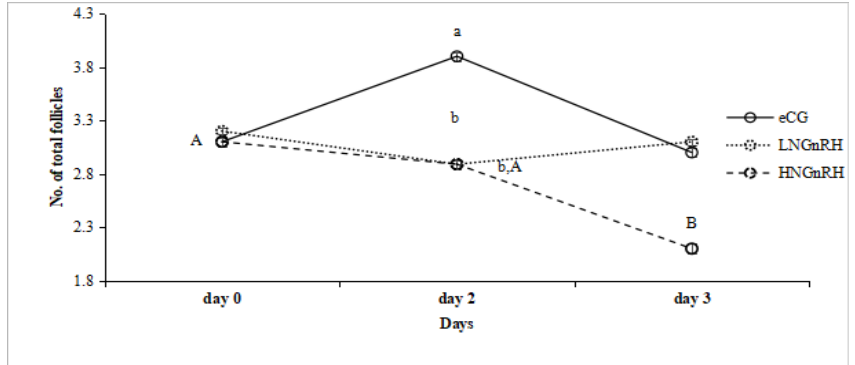
Figure 2. Follicular dynamics (small follicles: ≥ 2–3 mm, medium follicles: >3–<5 mm, and large follicles: ≥ 5 mm) of ewes treated with equine chorionic gonadotropin (eCG, 350 IU/ewe) during CIDR removal or under different doses of nano-encapsulated gonadotropin releasing hormone (LNGnRH, 25 µ g/ewe and HNGnRH, 50 µ g/ewe) 48 h after CIDR removal. Day 0: day of CIDR removal. The a,b means with different superscripts on the same scanning day are significantly different at p < 0.05. The A,B,C means with different superscripts in the same experimental group are significantly different at p < 0.05.